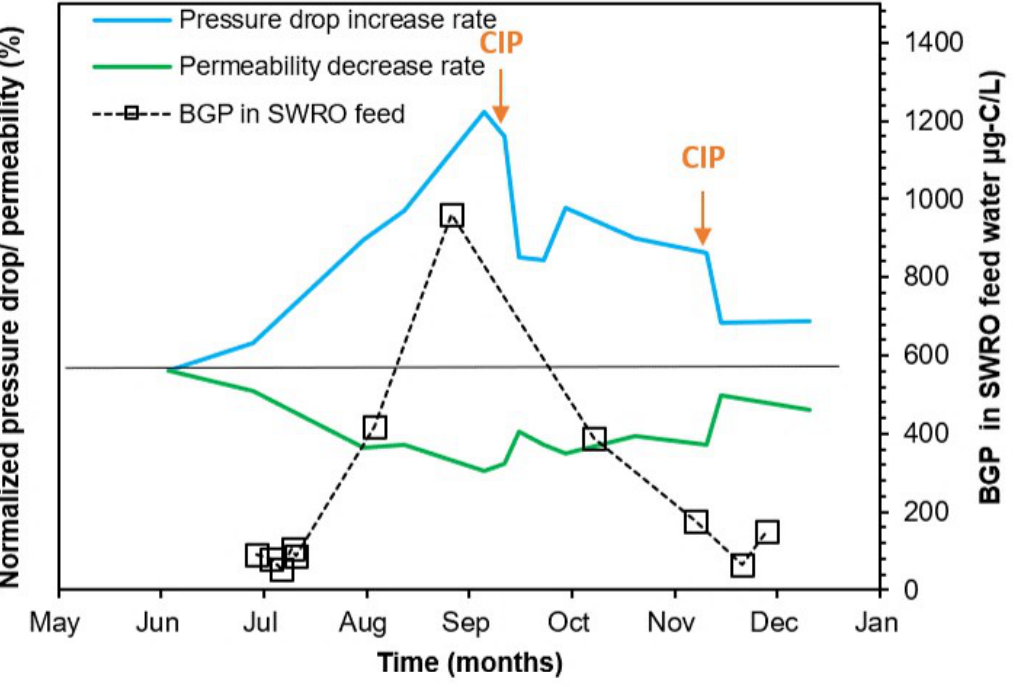
Figure 4. Correlation between BGP in the SWRO feed water and the normalized pressure drop and normalized permeability in the SWRO membrane system (n =